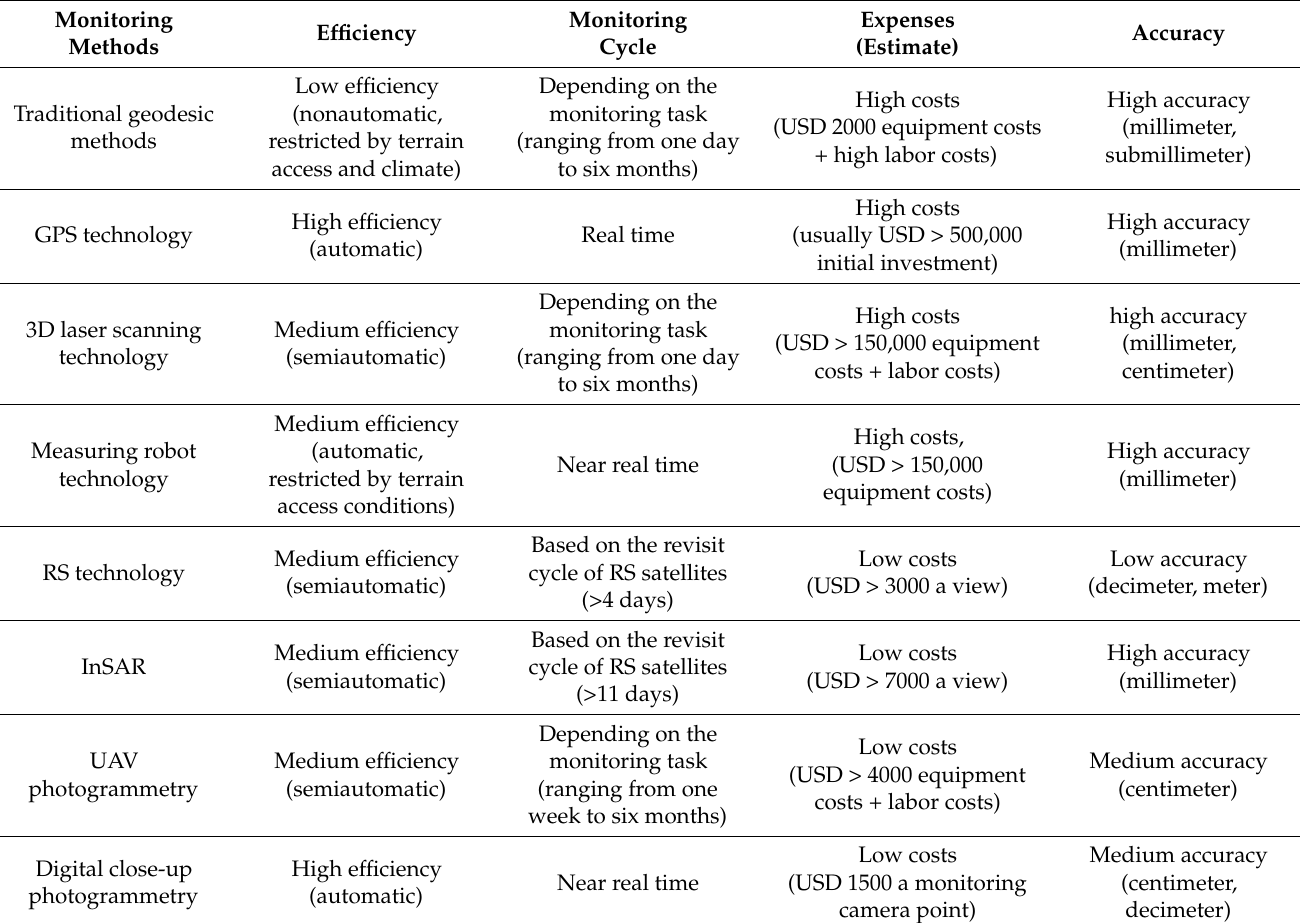
Table 1. Characteristics and application scope of the main monitoring methods employed for open-pit mine slopes.